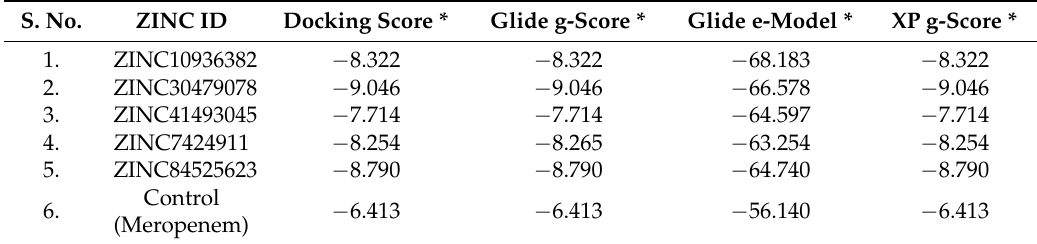
Table 1. The extra precision (XP) docking parameters of the identified compounds by high precision virtually screening (HTVS) and standard precision (SP)